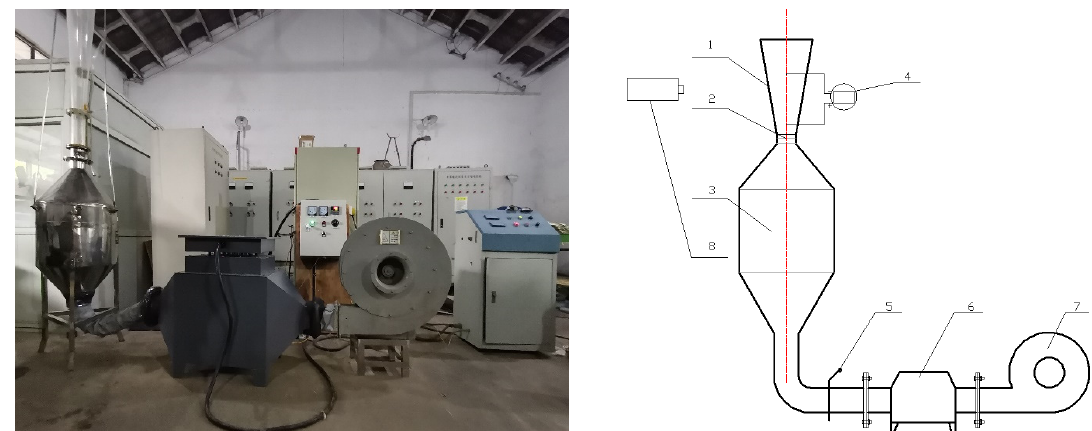
Figure 2. Scheme of the drying fluidized bed. 1. observed pipe; 2. asbestos net; 3. steady flow cylinder; 4. measuring port; 5. damper; 6. heating; 7. centrifugal fan; 8. high-speed camera.